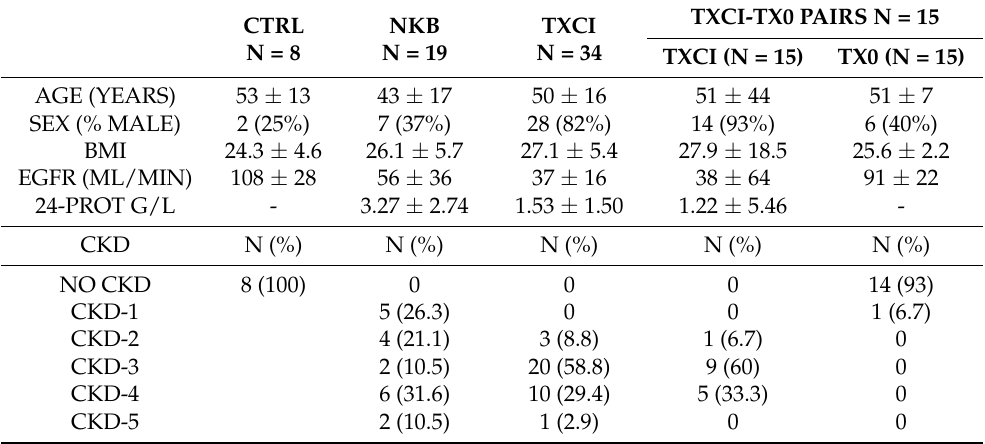
Table 1. Study group characteristics for ADAMTS-4 and BMP-1 immunohistochemistry analysis of kidney biopsy tissue